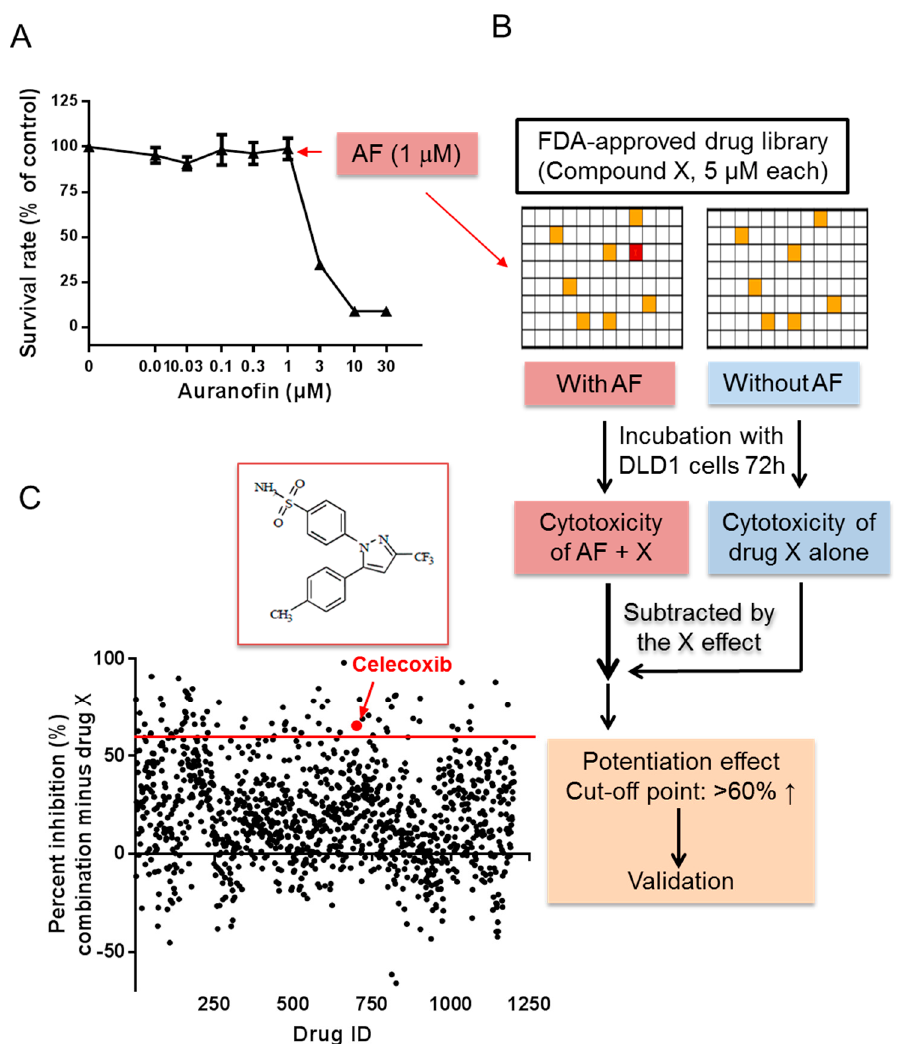
Figure 1. High-throughput screening of drugs that enhance the anticancer efficiency of auranofin (AF). ( A ) Dose–response curves of auranofin treatment for 72 h for DLD-1 cells using MTS assay. ( B ) Scheme showing high-throughput screening for 1280 FDA-approved compounds that enhance the anticancer efficiency of auranofin in DLD-1 cells. ( C ) In this screening, 1 μ M AF and 5 μ M drug X were used. The inhibition ratio of cell growth increased at least 60% between combination therapy and drug X was considered as a potential target. High-throughput screening (HTS) data of 1280 drugs combined with AF using DLD-1 cells; the red line indicates the threshold (>60 inhibition elevated); the red arrow and dot indicate the final candidate, celecoxib. Data are presented as the mean ± standard deviation (SD) of a triple assay.